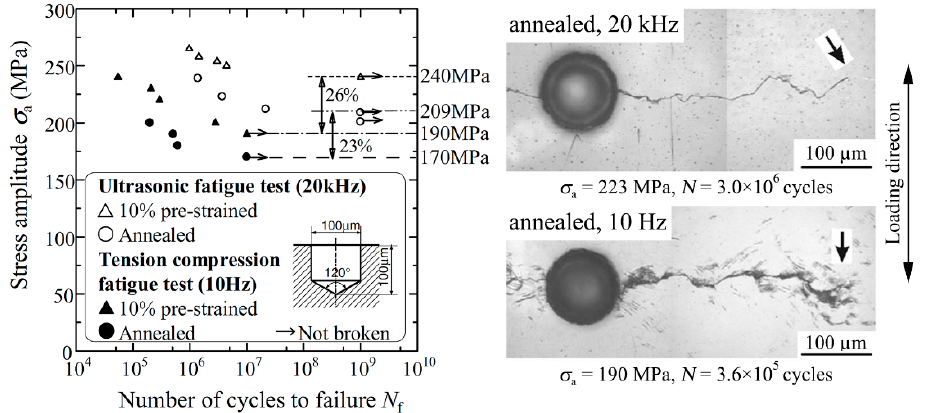
Figure 9. Servo ‐ hydraulic and ultrasonic tension ‐ compressions fatigue test results with annealed Figure 9. Servo-hydraulic and ultrasonic tension-compressions fatigue test results with annealed and 10% pre-strained low and 10% pre ‐ strained low carbon steel specimens containing 1 ‐ hole defects; reprinted with permis ‐ carbon steel specimens containing 1-hole defects; reprinted with permission from John Wiley and Sons sion from John Wiley and Sons [52].